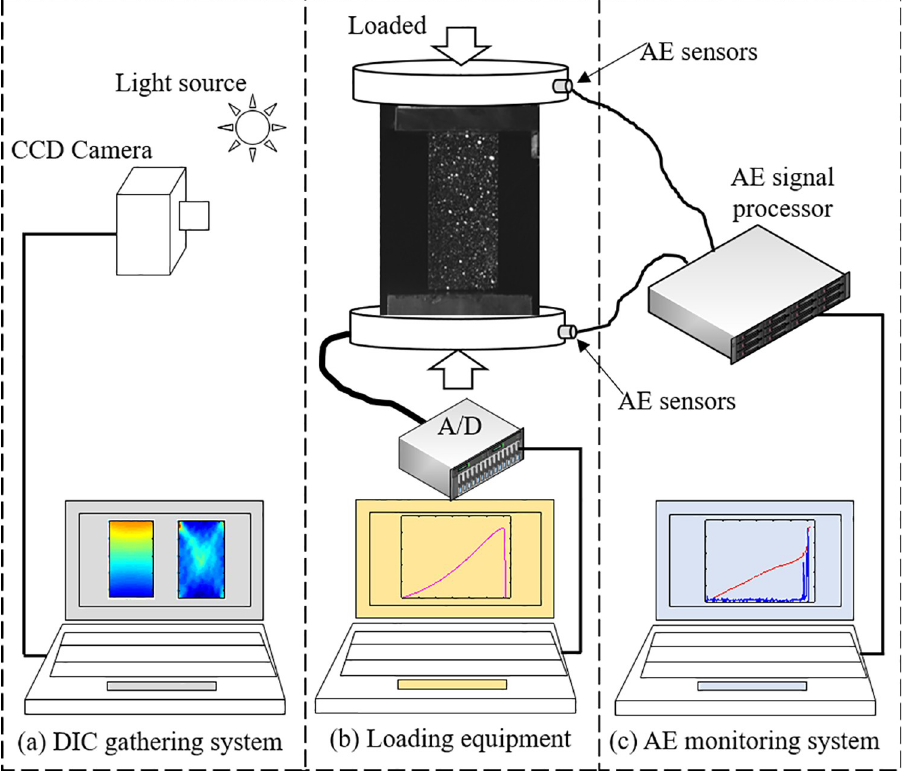
Fig 2. Layout of loading equipment and monitoring